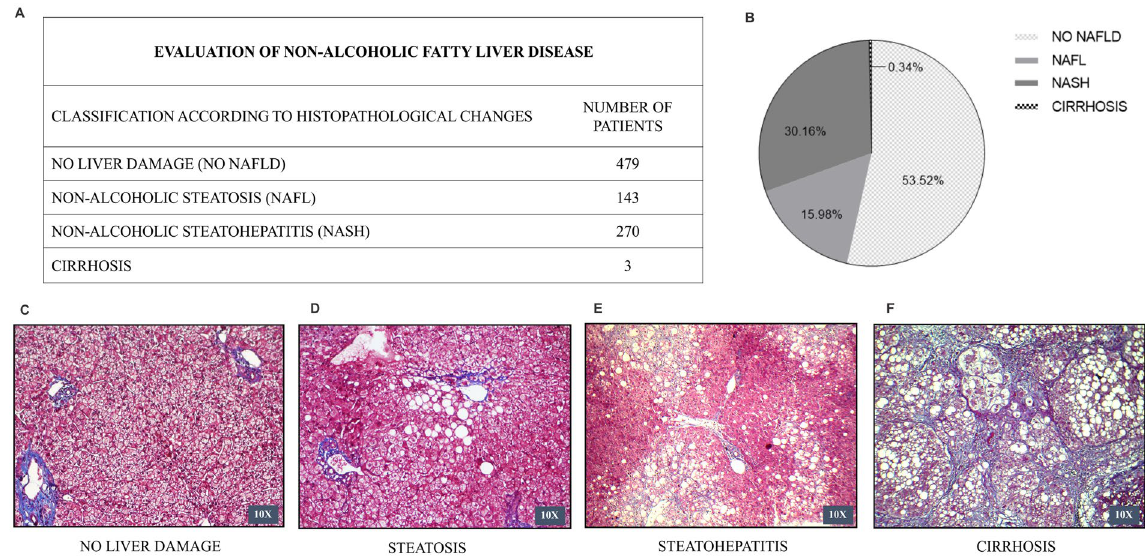
Figure 2. Histological evaluation of non-alcoholic fatty liver disease in the obese patients who underwent bariatric surgery – Retrospective cross-sectional analysis. Liver biopsies were performed during the bariatric surgery in the Clinical Hospital by the Surgery Department of the University of Campinasfrom 2008 to 2019. Number of patients included in the study = 895. ( A) Classification of the NAFLD according to the histopathological changes. ( B) Percentage of patients that were classified in each histological category: no liver damage, steatosis, steatohepatitis and cirrhosis. ( C–F) Representative images of Masson’s Trichrome staining showing no histological change in the liver ( C ), hepatocytes displaying vacuoles related to triglyceride accumulation (macrogoticular steatosis) ( D ), hepatocellular ballooning (Mallory hyaline), macrogoticular steatosis and perisinusoidal fibrosis in acinar zone 3 ( E ), steatohepatitis with distortion of lobular architecture, collagen fibers highlighted in blue delineate hepatocytes forming septa that join portal structures and lobular center, in nodular transformation (cirrhosis) ( F ). 10 × objective lenses were used as indicated in each